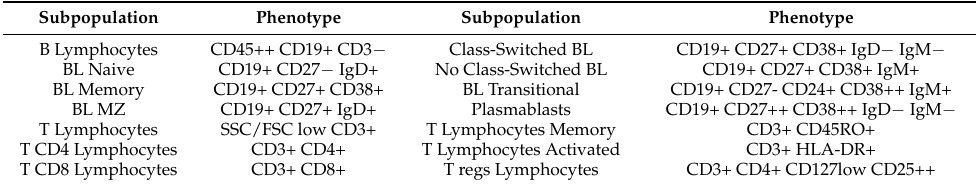
Table 4. The phenotype of lymphocyte